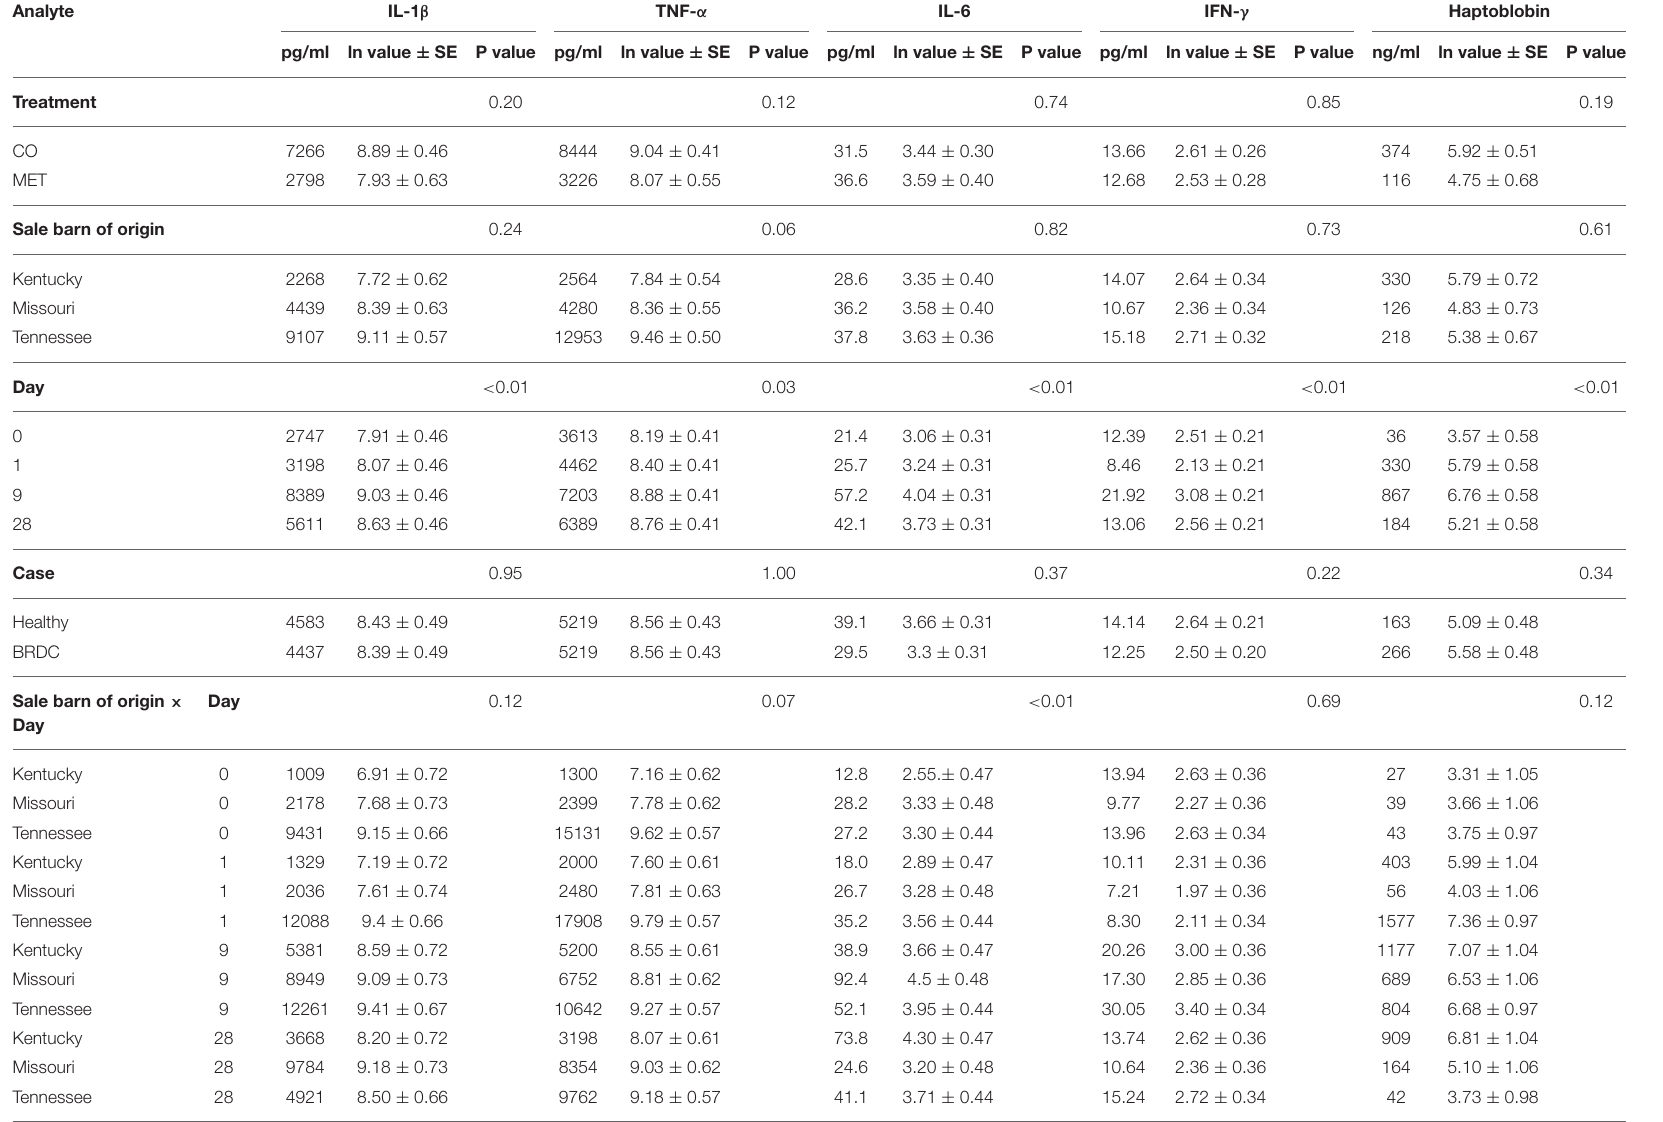
TABLE 1 | Bovine cytokine and haptoglobin concentrations.